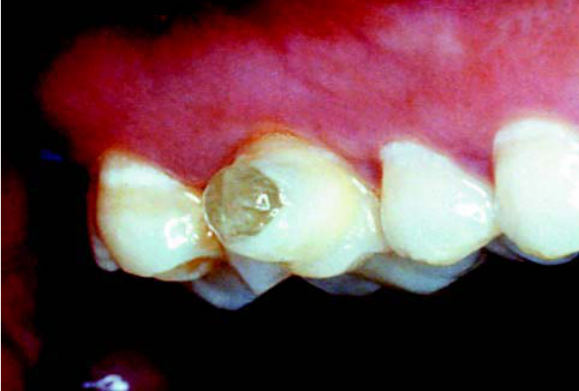
FIGURE 3- Kidney-shaped device bonded to the upper first permanent molar tooth